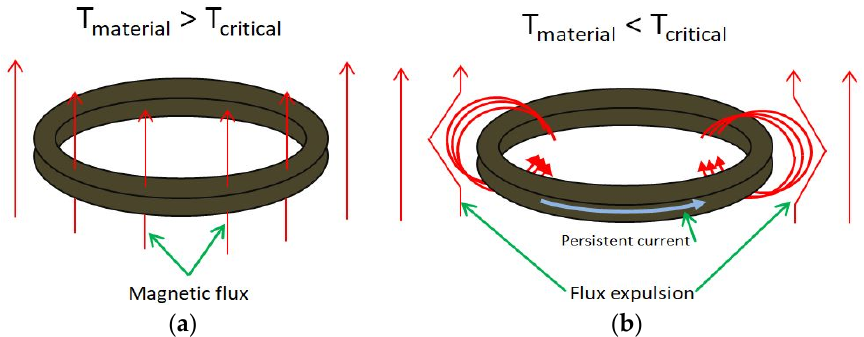
Figure 2. Magnetic field lines around normal state conductor and superconductive state conductor. ( a ) A temperature higher than the critical temperature of a superconductor does not influence mag ‐ netic field lines; ( b ) During the superconductive state, magnetic field lines induce a surface current through the superconductor. This leads to magnetic levitation, since incident magnetic field lines are expelled.